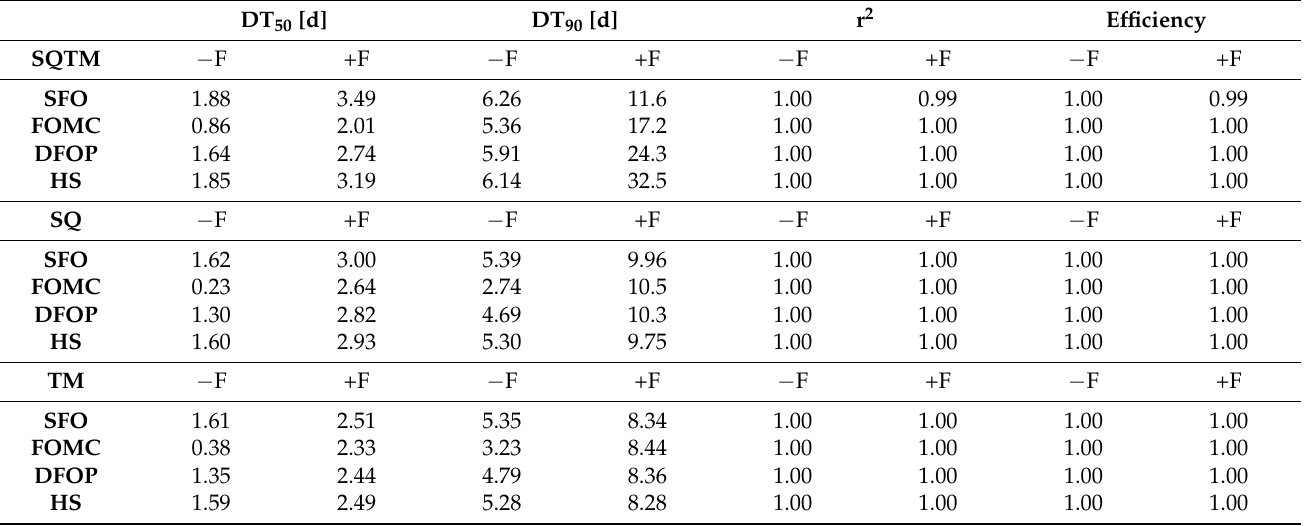
Table 1. Dissipation kinetics of MCPA for the controls ( − F) and fungicide treatment scenarios (+F): combination (SQTM), spray series (SQ), and tank mix (TM). SFO: single first-order; FOMC: first- order multi-compartment; DFOP: double first-order in parallel; HS: hockey stick. The DT 50 , DT 90 , coefficient of determination (r 2 ), and efficiency were calculated with CAKE version 3.4. The mean values and standard deviations were derived from triplicates (n =